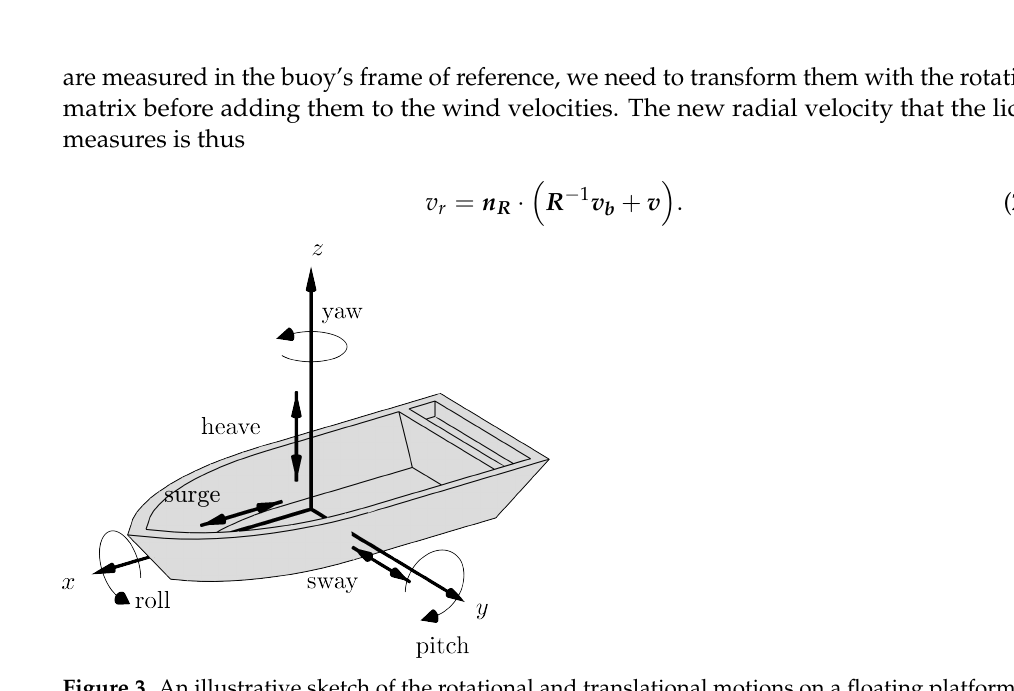
Figure 3. An illustrative sketch of the rotational and translational motions on a floating platform.